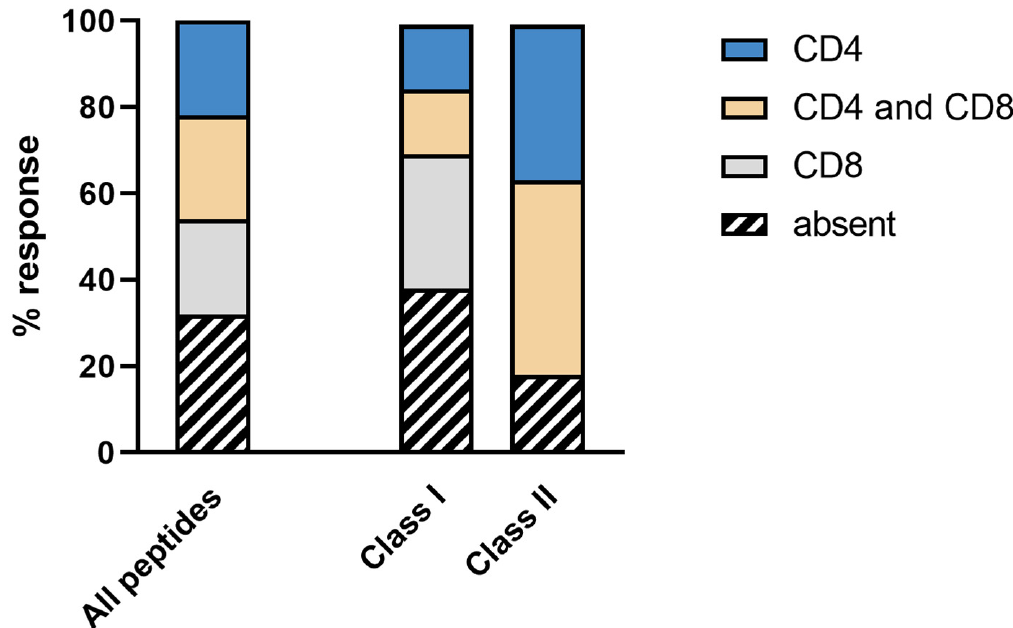
Figure 3. Immunogenicity of vaccinated peptides. Percentages of durable vaccine-induced immune responses. In total, 37 different peptides were vaccinated (26 HLA class I peptides and 11 HLA class II peptides). We distinguished between immune responses solely mediated by CD4+ (blue), immune responses solely mediated by CD8+ (gray), immune responses mediated by both CD4+ and CD8+ (sand), and no response (black shaded). Immune responses were defined as being durable if they were detected at two time points.